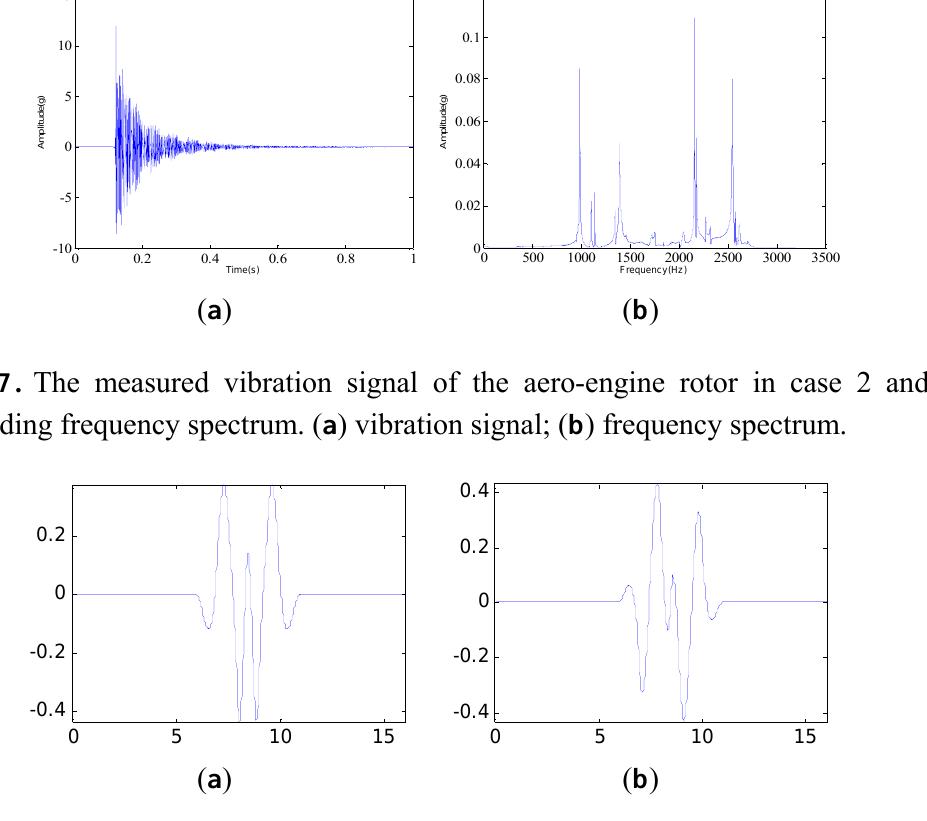
Figure 18. The multiwavelet